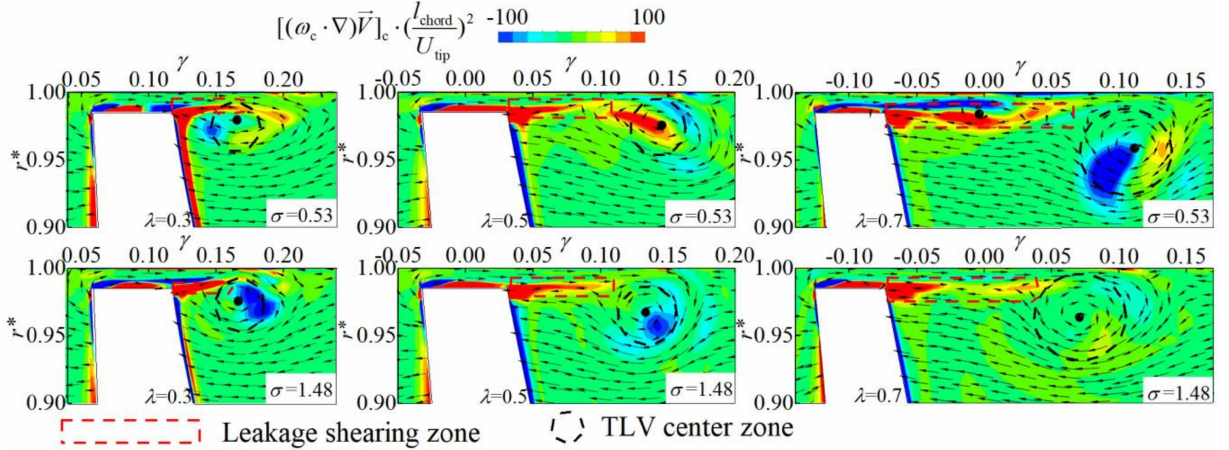
Figure 18. Comparison of the stretching term distribution on the three planes for the cavitating case ( upper ) and non- cavitating case ( lower